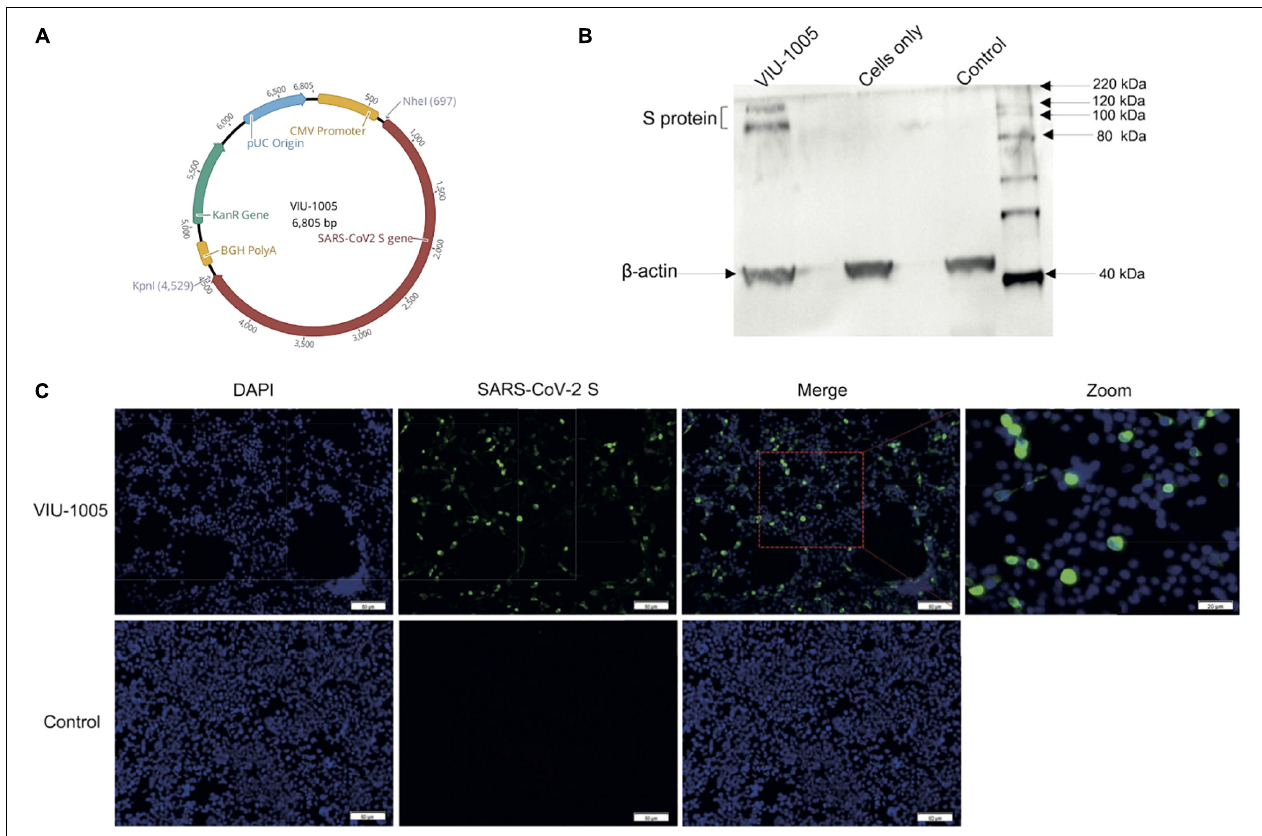
FIGURE 1 | Vaccine design and expression of SARS-CoV-2 spike protein. (A) Schematic diagram of the SARS-CoV-2 DNA vaccine construct (VIU-1005). The SARS-CoV-2 spike gene is indicated by red color. (B) Western blot showing the expression of S protein at the expected size from HEK293 cells transfected with VIU-1005 construct only but not cells transfected with control plasmid or cells only control. (C) Immunofluorescent staining of cells transfected with VIU-1005 or control plasmid. Transfected cells were stained with anti-SARS-CoV-2 S rabbit polyclonal antibodies (green), and nuclei were counterstained with DAPI (blue). Scale bars are depicted in each